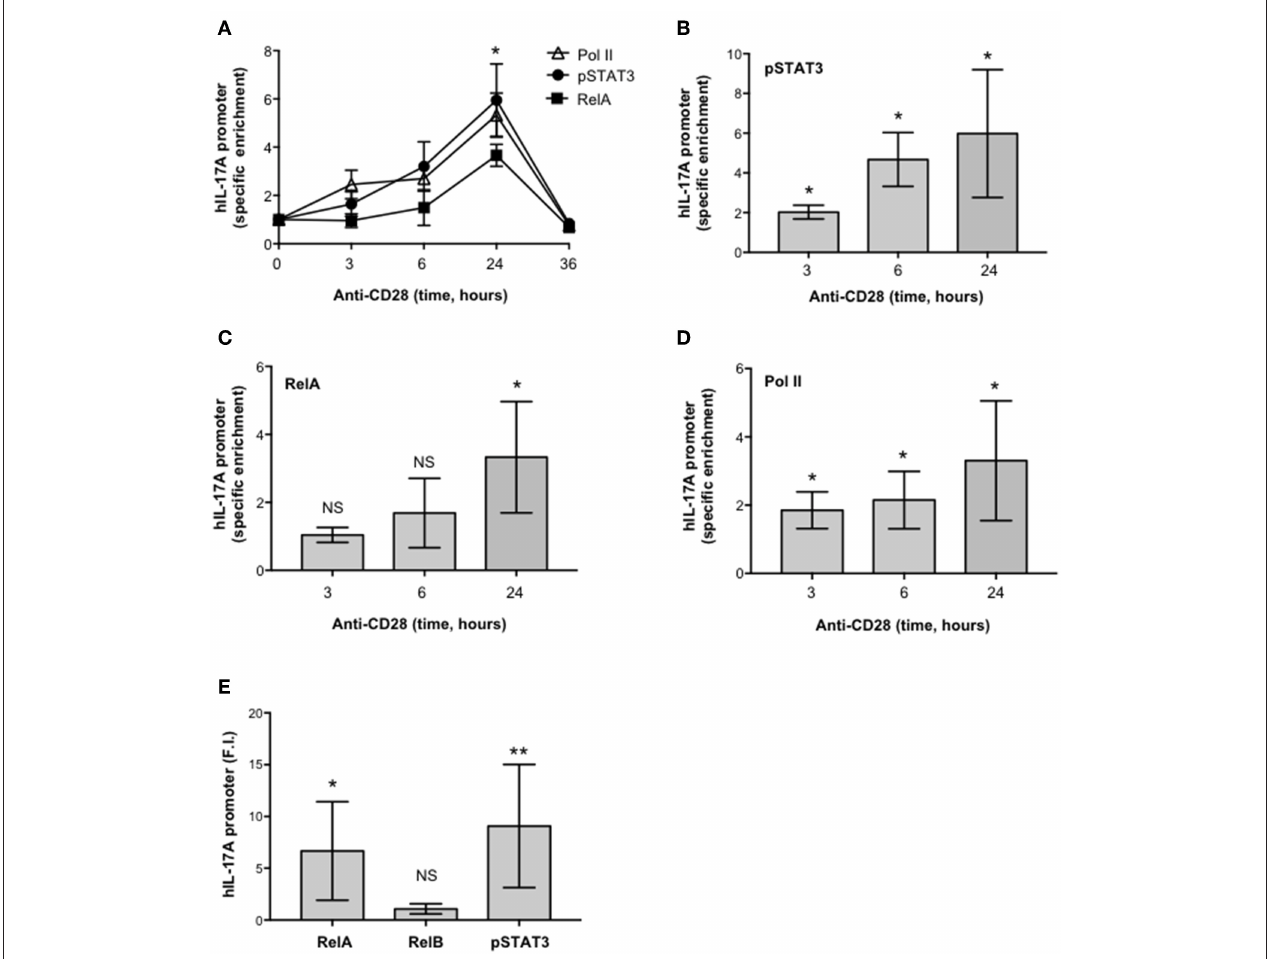
FIGURE 6 | CD28 stimulation of human CD4 + T cells induces the selective recruitment of RelA and pSTAT3 to IL-17A promoter. (A) CD4 + T cells were stimulated for the indicated times with anti-CD28.2 Abs and anti-RelA, anti-pSTAT3, and anti-Poll II ChIPs were performed. Immunoprecipitated DNA was analyzed by real time PCR with IL-17A promoter specific primers. Specific enrichment over isotype control Abs was calculated by the C τ method. Data express the mean ± SD of one representative experiment. Significance was calculated by Student t -test. (A–D) Real time PCR for IL-17A promoter from anti-pSTAT3 (B) , anti-RelA (C) , anti-Pol II (D) ChIPs performed on CD4 + T cells from HD ( n = 4) stimulated for the indicated times with isotype control or anti-CD28.2 Abs. Specific enrichment over isotype control Abs was calculated by the C τ method. Data express the mean ± SD of four independent experiments. Significance was calculated by Student t -test. * p < 0.05, ** p < 0.01, NS, not significant. (E) Real time PCR for IL-17A promoter from anti-RelA, anti-RelB, and anti-pSTAT3 ChIPs performed on CD4 + T cells from HD ( n = 6) stimulated for 24h with isotype control or anti-CD28.2 Abs. Specific enrichment over negative control Abs (anti-Lck) was calculated by the C τ method and data expressed as fold inductions (F.I.) over isotype control Ig-stimulated cells. Data express the mean F.I. ± SD. Statistical significance was calculated by Student t -test. * p < 0.05, ** p < 0.01, NS, not significant. Mean ± SD: RelA = 6.7 ± 4.8, RelB = 1 ± 0.4, pSTAT3 = 9 ±